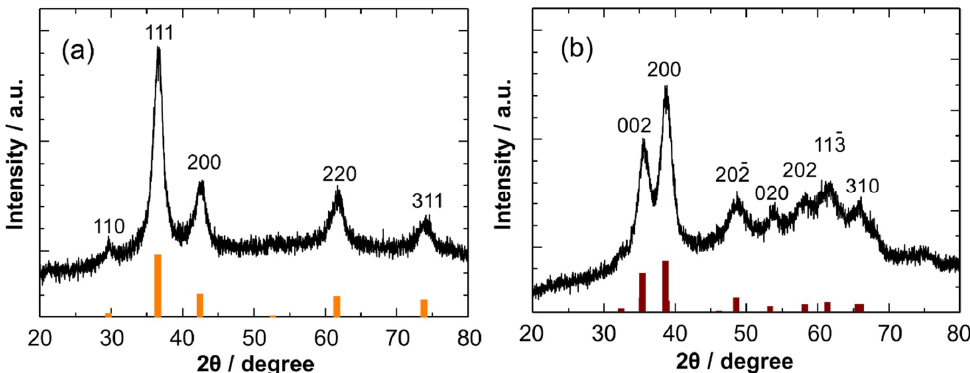
Figure 2. XRD patterns of ( a ) Cu 2 O (JCPDS file no. 05-0667) and ( b ) CuO NCs (JCPDS file no. 45-0937). CuO NCs were obtained by air oxidation of Cu 2 O NCs at room temperature.